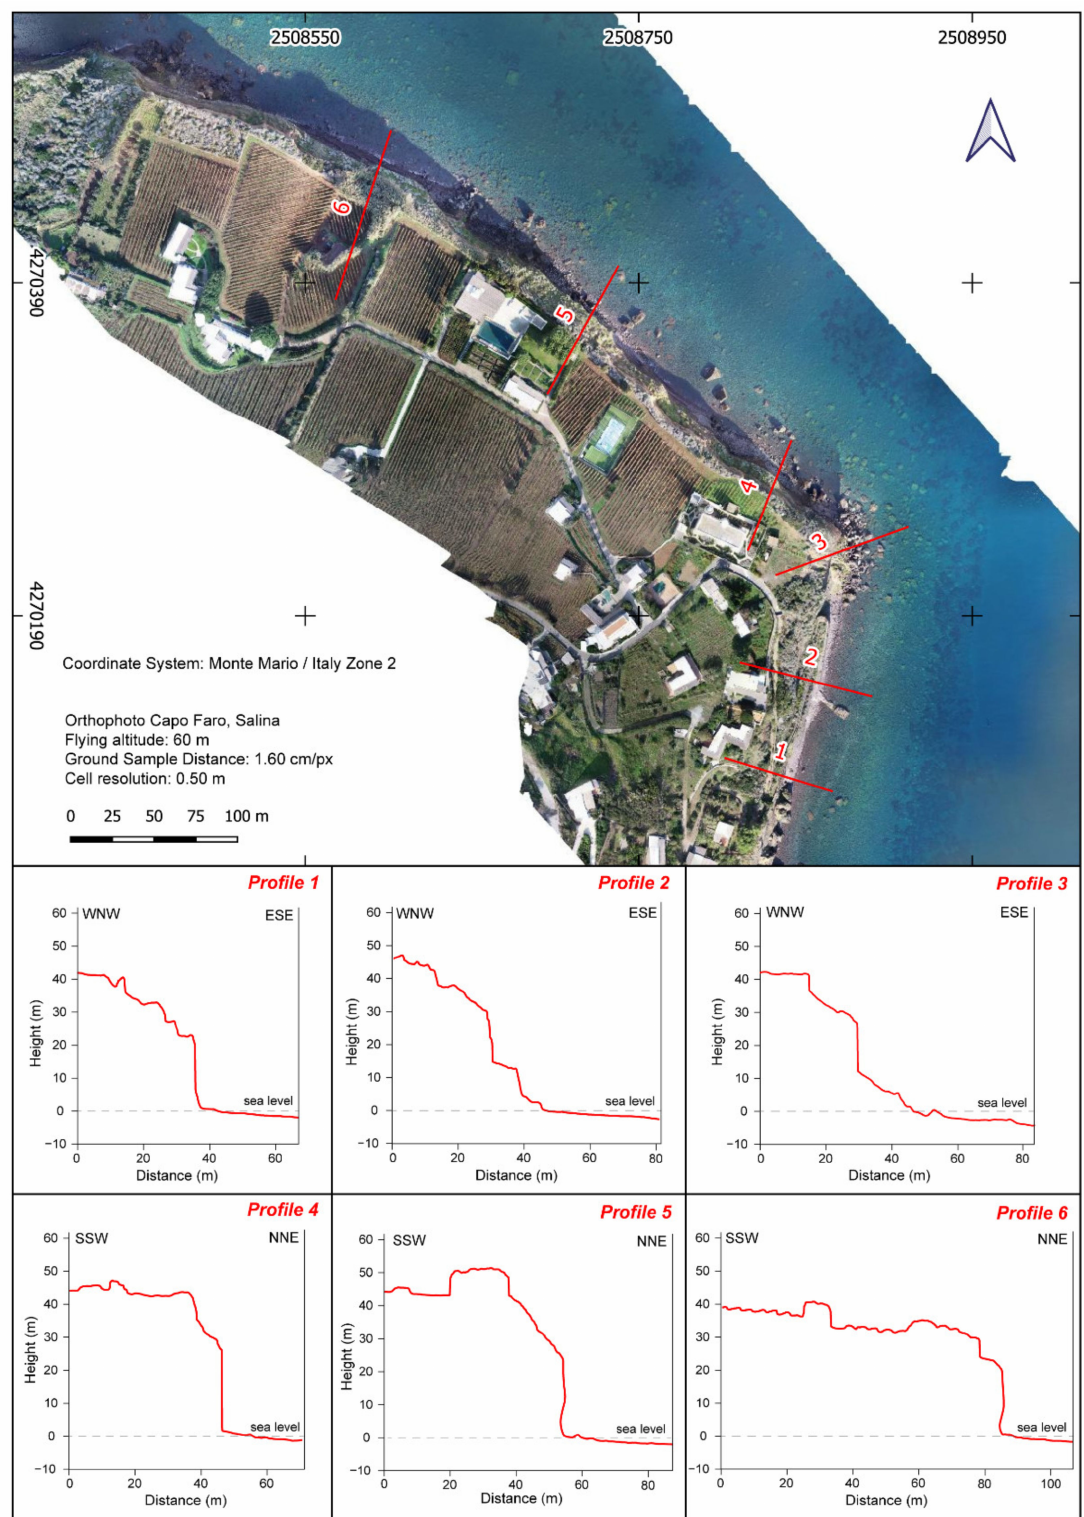
Figure 5. The 2D orthophoto, generated by a 60 m altitude UAV flight, on which six topographic profiles have been traced. As highlighted by profiles 4 and 5, the relief energy is higher in correspon- dence with the Capo Faro vineyard and the Capo Faro Estate, respectively. Profiles 3, 4 and 5 show a clear vertical cliff. Profiles 5 and 6 evidence the etched swash line at about 5 m